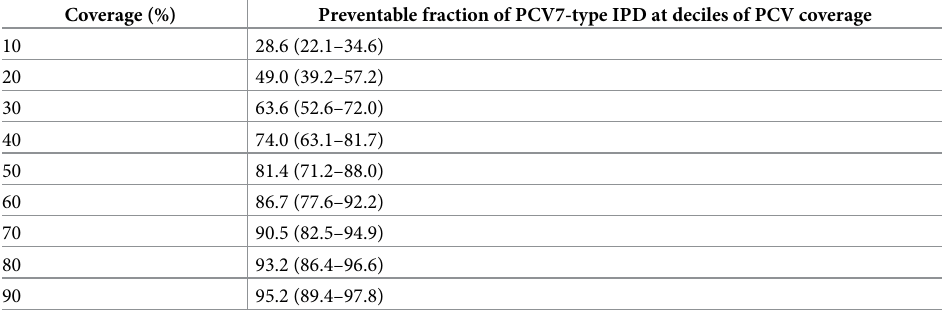
Table 5. Preventable fraction of PCV7-type IPD in undervaccinated children under 5 years at deciles of PCV cov- erage, New South Wales and Western Australia, 2001–2012.